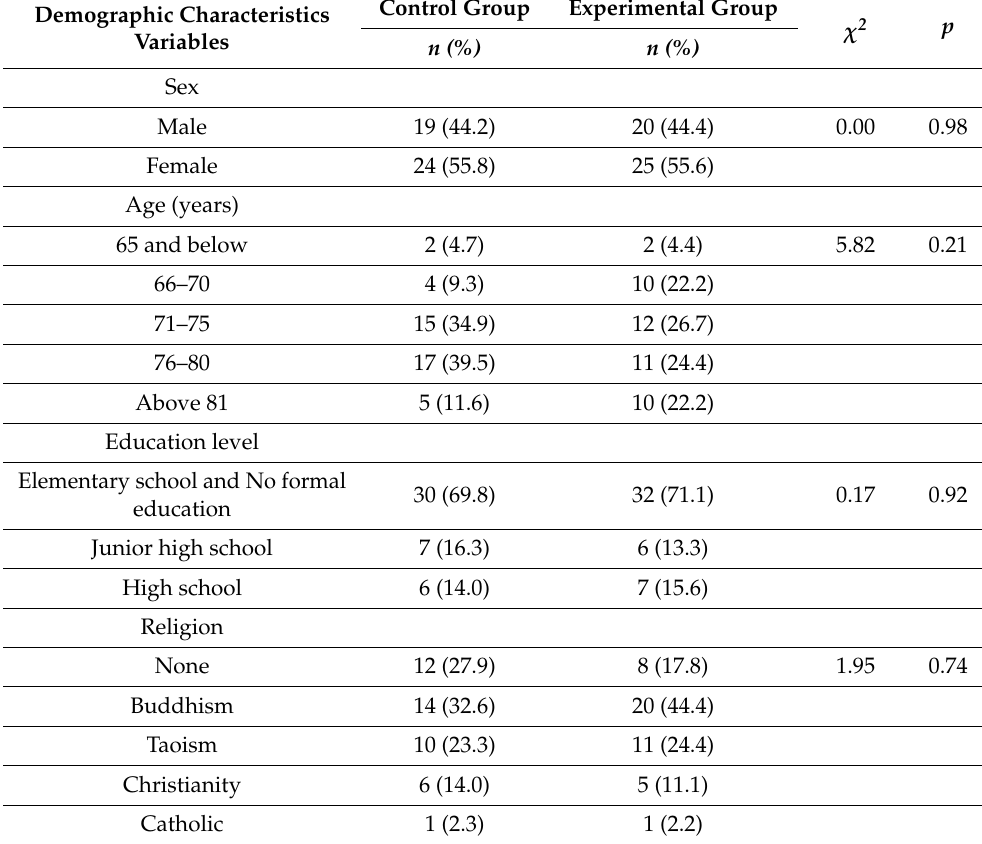
Table 2. Results of the chi-squared test of baseline demographic characteristics in the experimental and control